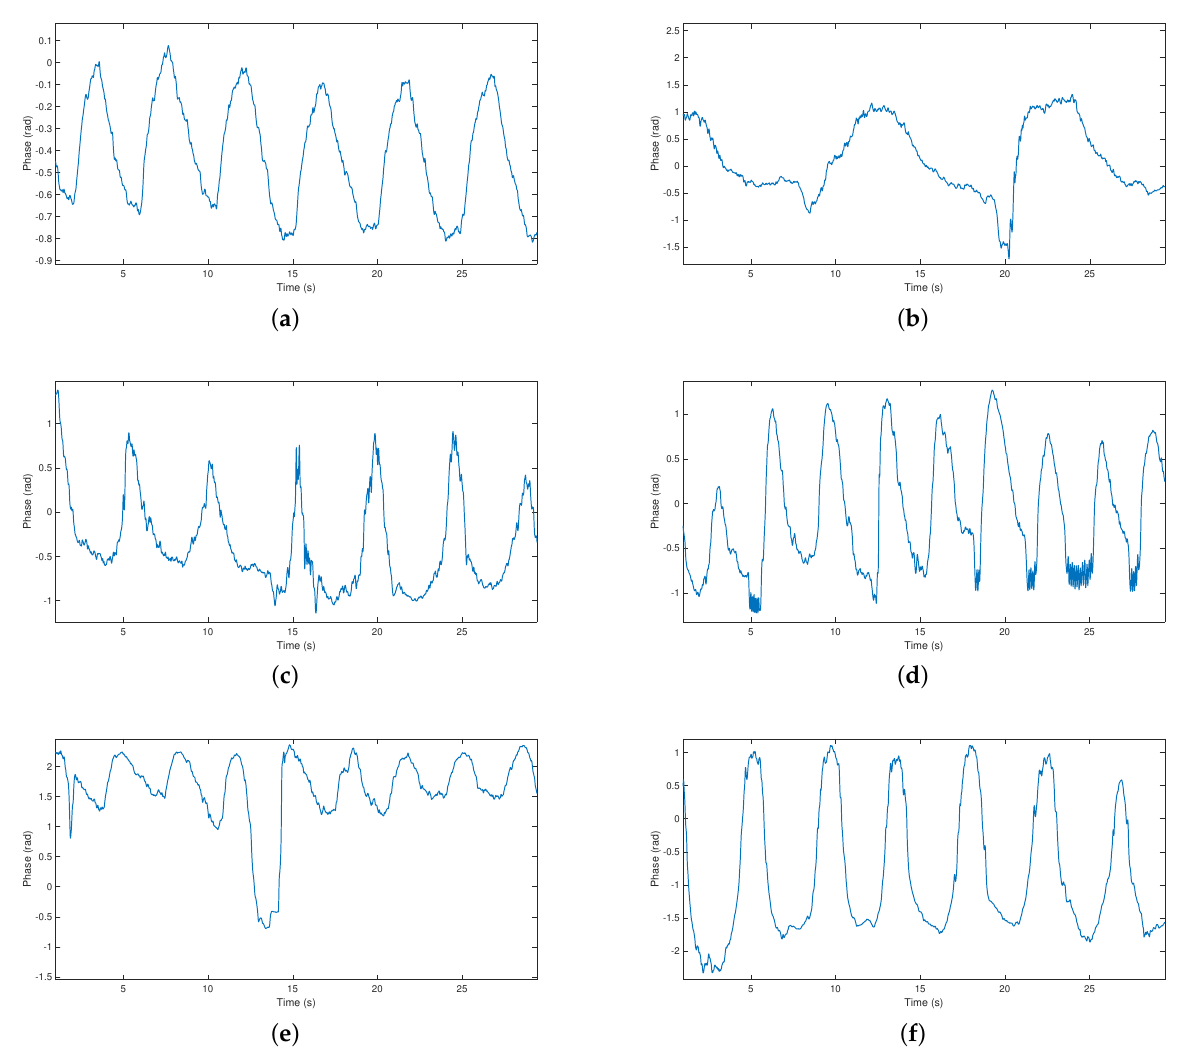
Figure 20. Respiratory signals of six subjects detected using textile antennas: ( a ) subject 1, ( b ) subject 2, ( c ) subject 3, ( d ) subject 4, ( e ) subject 5, ( f ) subject